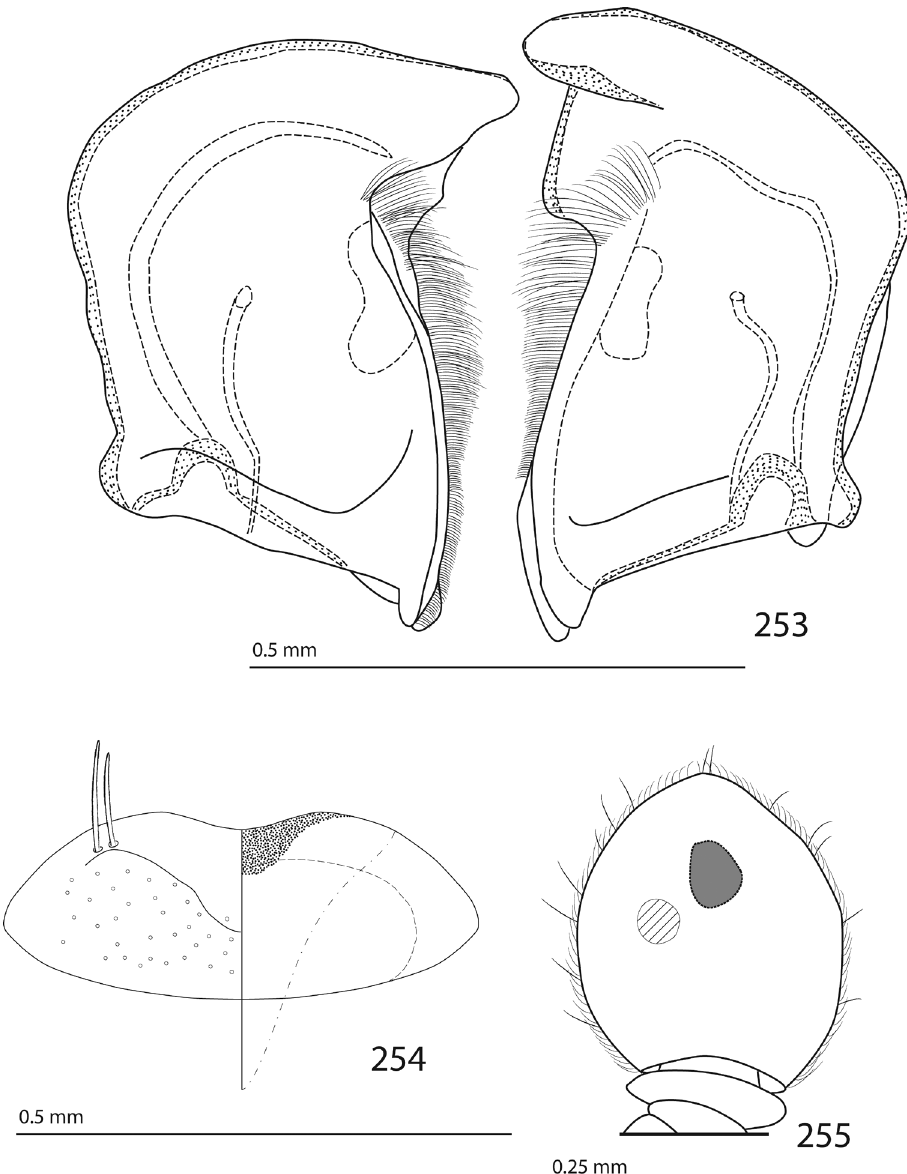
Figures 253–255. 253 Reichardtia pedator (Sharp, 1876) mandibles, dorsal view 254 labrum: left half depicting dorsal view and right half depicting epipharynx 255 antennal club, ventral view showing sen- sory structures of the